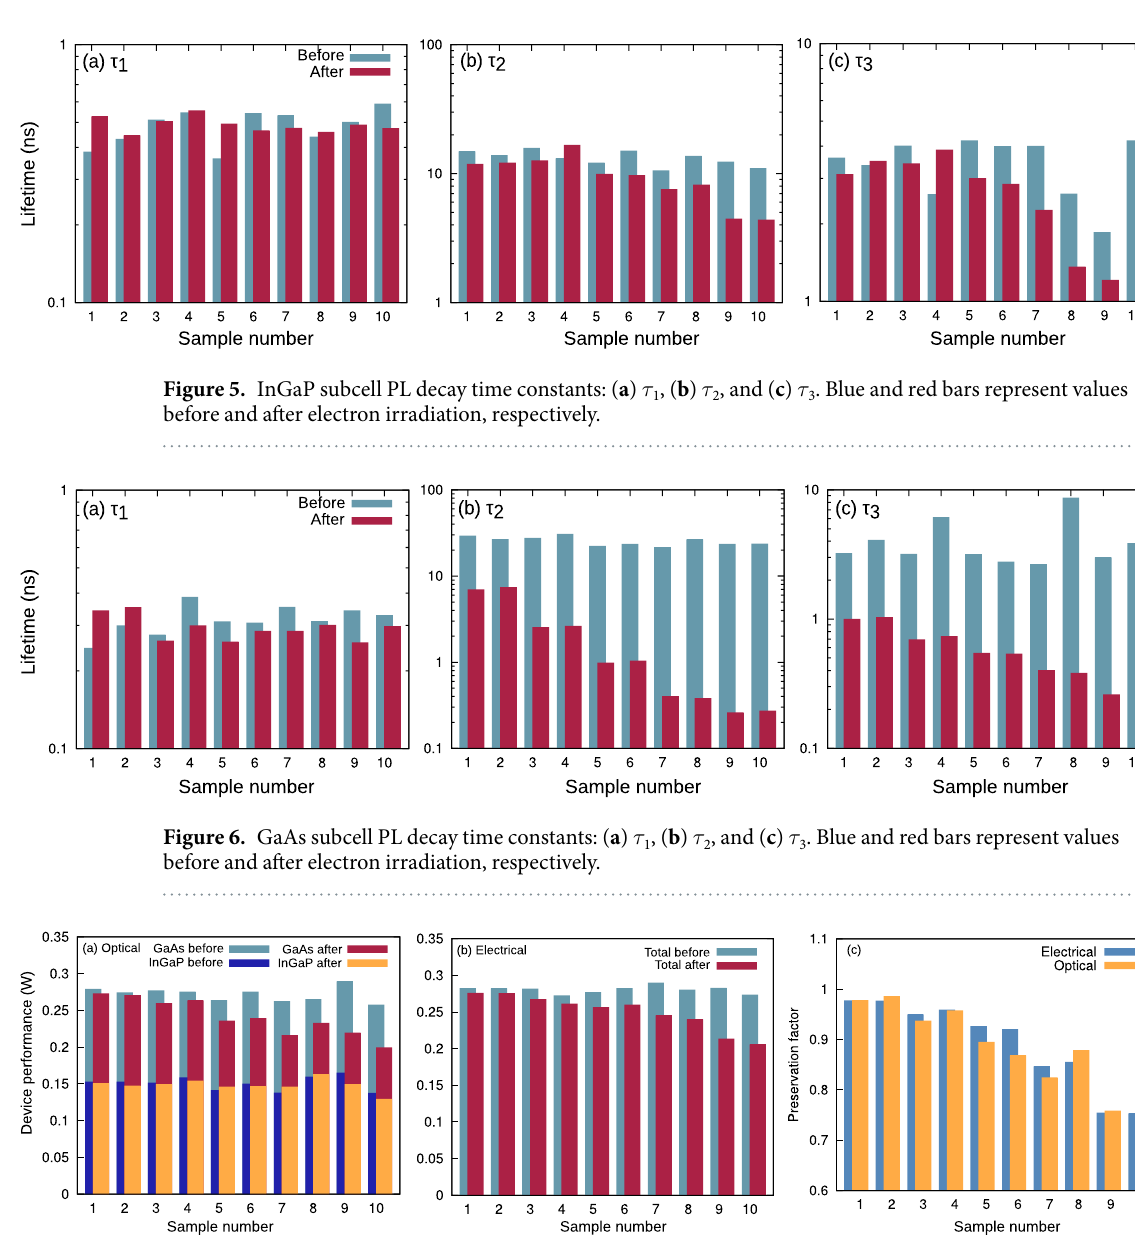
Figure 7. Comparison of optically and electrically obtained solar cell performance. ( a ) Subcell and total device performance predicted using optical measurements. ( b ) Electrically measured output power of the total device. ( c ) Optically and electrically measured preservation factors relating output power of the device before and after